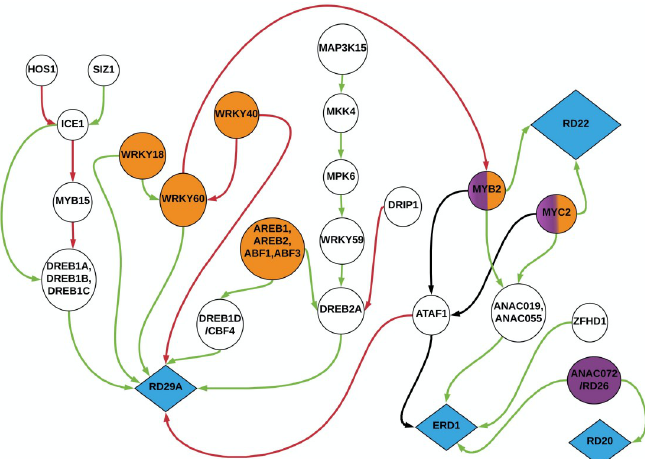
Fig 1. Drought signaling pathways in Arabidopsis. The orange circular nodes represent elements directly regulated by ABA whereas the purple nodes represent elements regulated by JA. The two nodes colored with a mix of orange and purple represent elements regulated by both JA and ABA pathways (Crosstalk). The blue diamonds represent drought responsive reporter genes. The plain circular nodes with no colors represent the transcription factors, genes and proteins involved in the regulation of drought responsive reporter genes in an ABA independent manner. The green and red arrows represent positive and negative regulation. The arrows going into and out of ATAF1 are marked black to indicate that the nature of regulation is not known at this